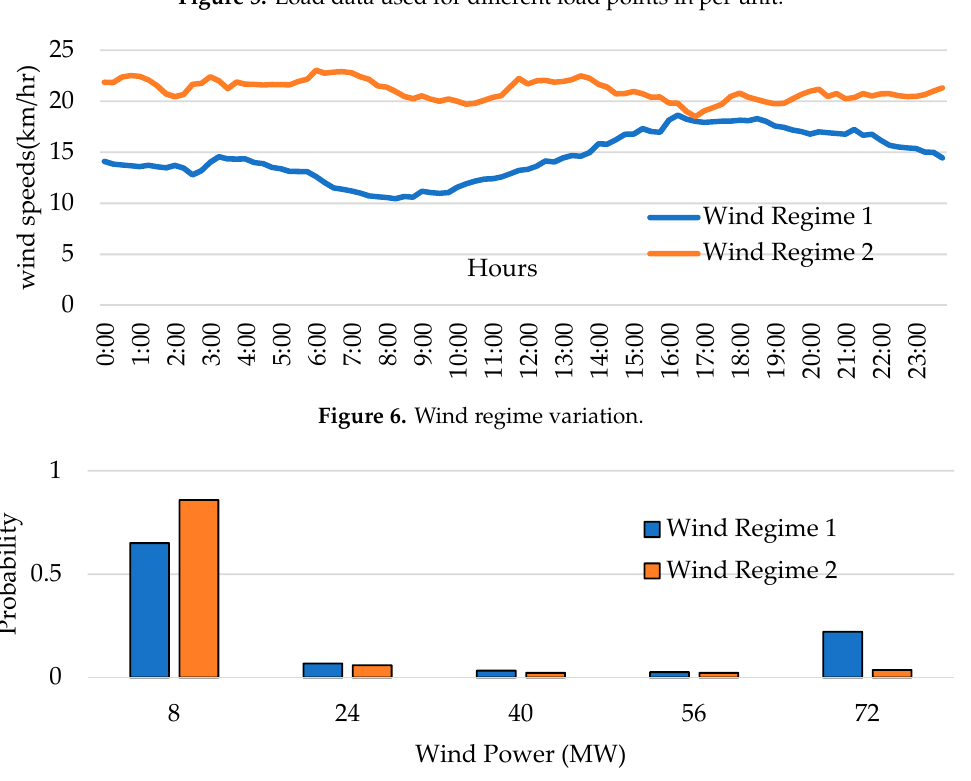
Figure 7. Wind power distribution associated with different wind regimes at the start of the evaluation period.